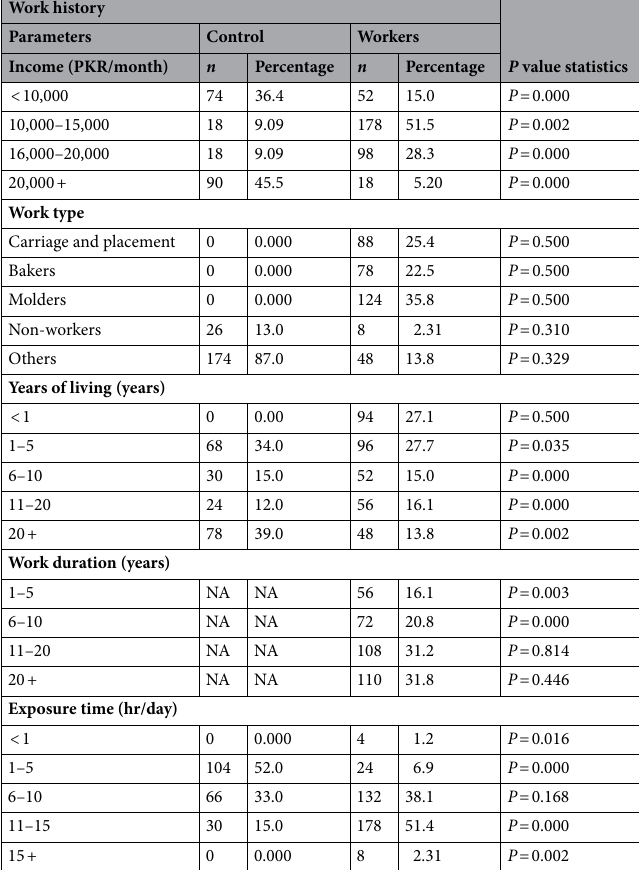
Table 2. Table showing work history of men working at brick kilns at Rawalpindi, Pakistan.